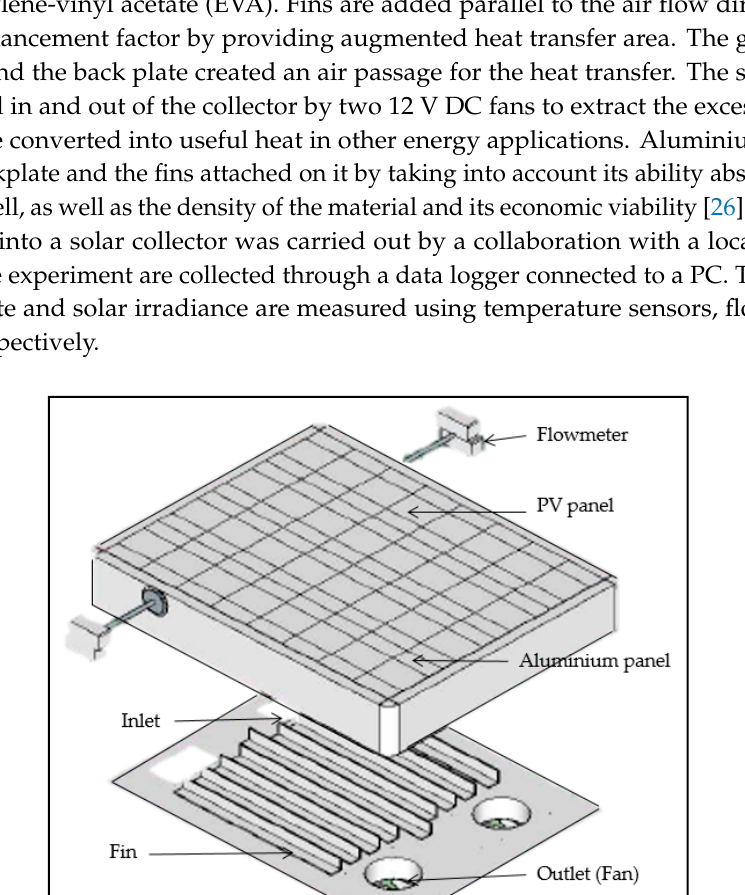
Figure 2. Cross sectional view of the PV/T solar collector.